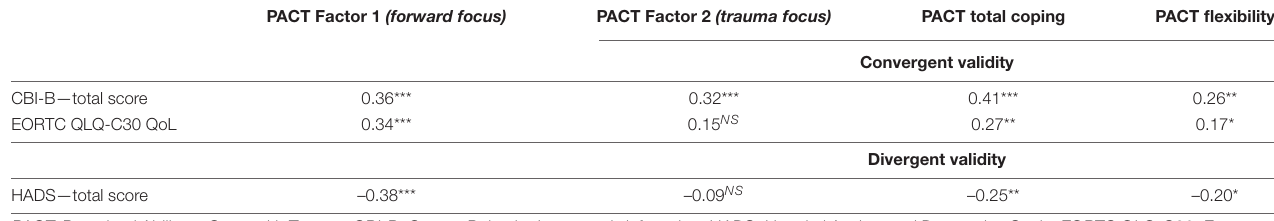
TABLE 3 | Convergent and divergent validities.